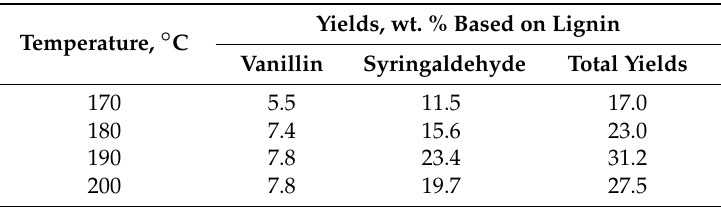
Table 3. The influence of temperature on yield of vanillin and syringaldehyde from the oxidation of aspen wood by oxygen in alkaline media (see references